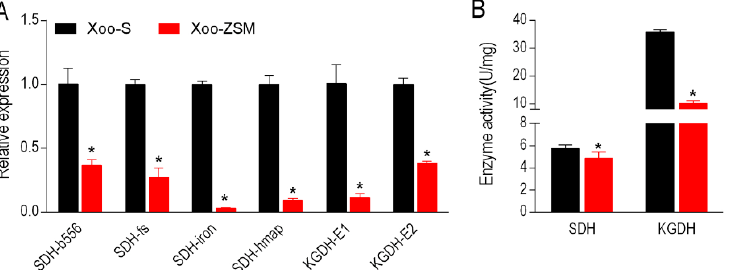
Figure 4. The attenuated P cycle in Xoo-ZSM. ( A ) The decreased expression levels of genes encoding two key enzymes in the P cycle. ( B ) The reduced activities of SDH and KGDH in Xoo-ZSM. The results are displayed as mean with SD, and significant differences were identified by Student’s t -test (* p < 0.05). At least three biological replicates were carried out.